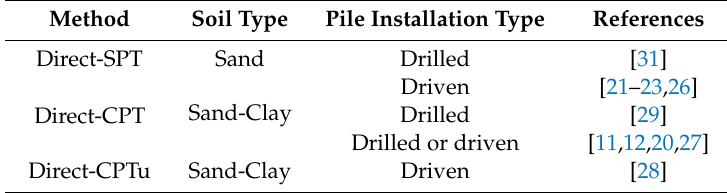
Table 1. Direct experimental methods for predicting the pile ultimate bearing capacity